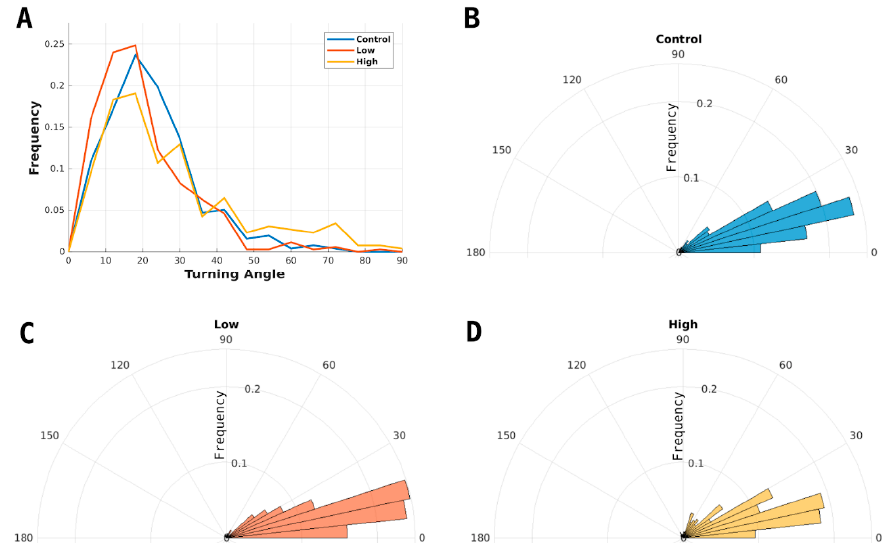
Figure 6. Frequency distribution of the turning angles (in degrees) of T. turbinata . ( A ) comparative histogram for the control and treatments, ( B–D ) turning angle frequencies for the control, low and high MP concentrations, respectively. The experimental conditions were the same as indicated in Figures 3–5.